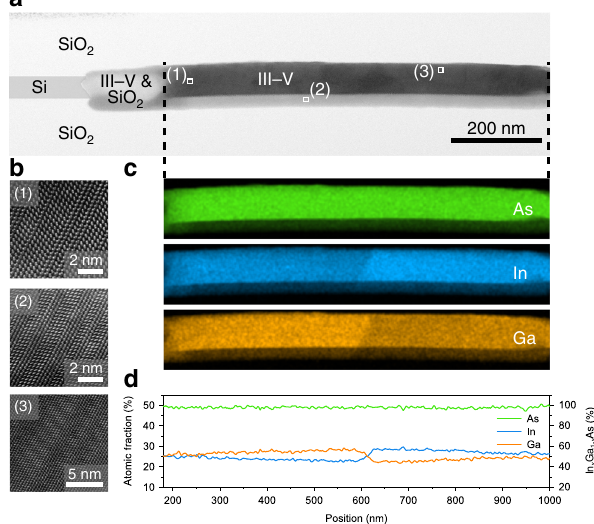
Fig. 3 Epitaxial single crystalline InGaAs nanostructure. a Bright fi eld STEM overview image of a 200 nm wide p – i – n nanostructure without contacts. The III – V material is grown from the Si in a funnel shape and hence, results in a thinner III – V region overlaid with SiO 2 at the Si interface which is visible as a brighter region. The Si seed is false colored to enhance visibility. b High resolution annular dark fi eld STEM images taken at marked positions in ( a ). c EDS analysis of the different elements in the In x Ga 1 − x As nanostructure. d Extracted atomic fraction along the nanostructure. Compositional line pro fi les obtained by averaging the integrated intensities over the nanostructure